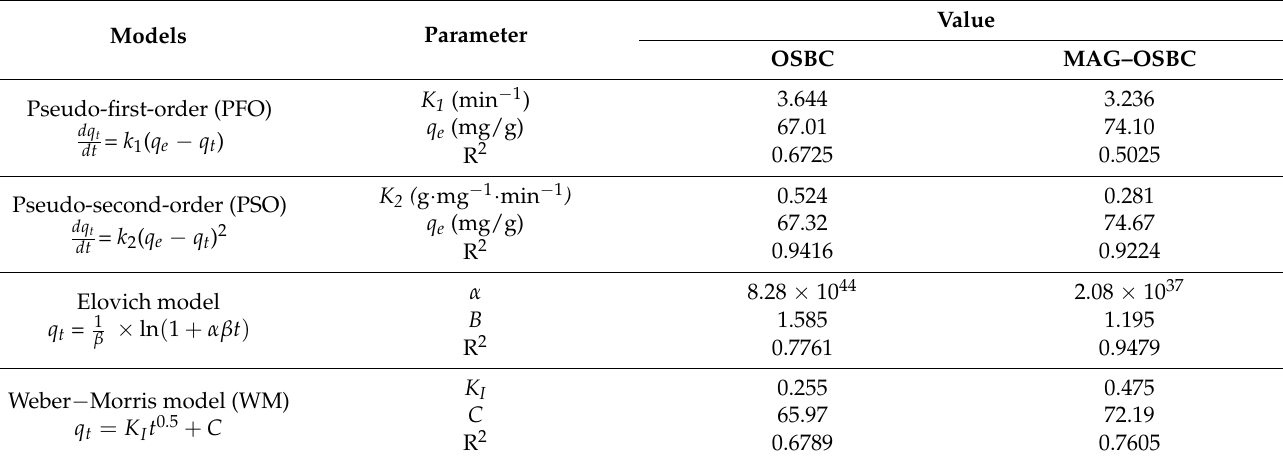
Figure 11. Kinetic models for the adsorption of CLOF onto ( a ) OSBC and ( b ) MAG–OSBC. Table 7. Data for the kinetic studies corresponding to the data shown in Figure